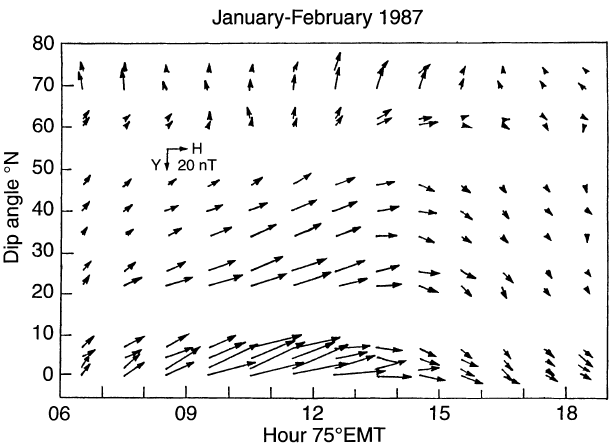
Fig. 4. The current vectors derived from ( D H ) and ( D Y ) at hourly intervals for each of the stations during